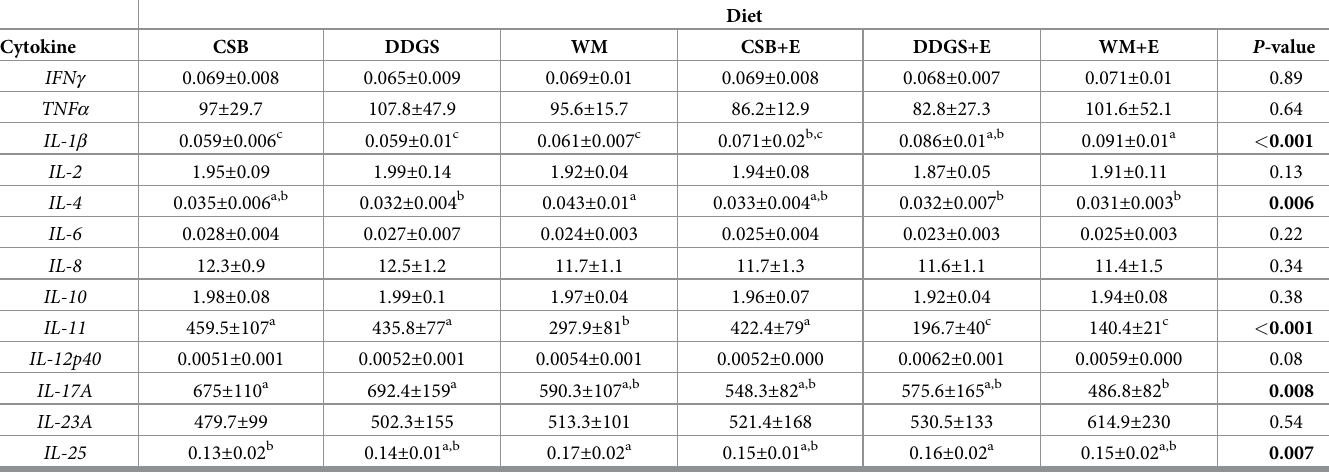
Table 3. Relative gene expression of cytokines in the ileum of pigs fed high-fiber diets with or without enzyme supplementation for 28 days.